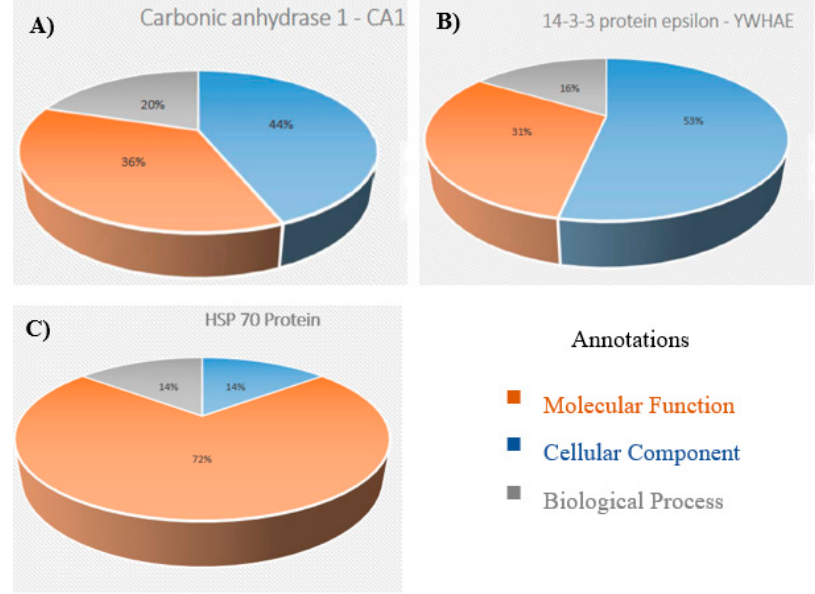
Figure 3. Functional classification of ( A ) CA 1, ( B ) 14-3-3 ε and ( C ) HSP 70 using the PANTHER gene ontology database.